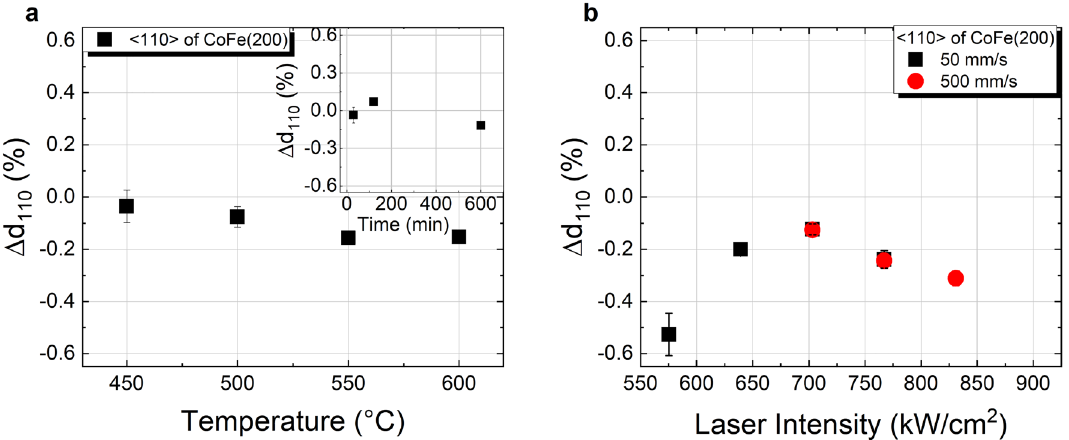
Figure 7. Deviation of d -spacing of CoFe(110) from the database value of Co–Fe for Co 40 Fe 40 B 20 capped with MgO/Ta annealed ( a ) in the furnace for 30 min at temperatures of 400 °C–600 °C and at 450 °C at different times (inset), and ( b ) annealed by cw laser irradiation at different scanning speed and laser intensity, calculated from the off-specular measurements (sample tilt of χ = 45°).